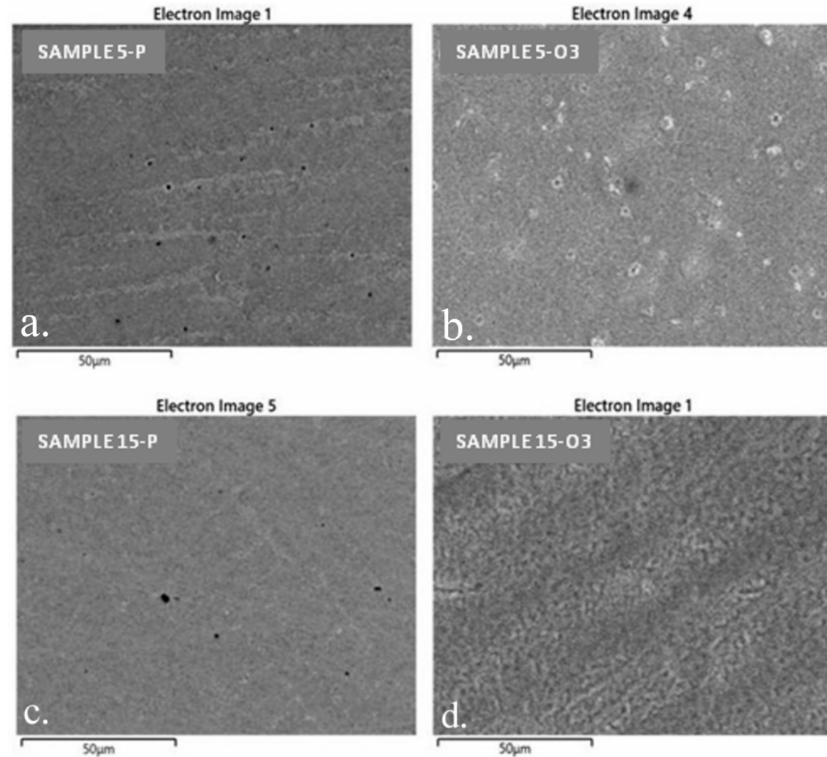
Figure 8. SEM images: ( a ) sample 5-P; ( b ) sample 5-O3; ( c ) sample 15-P; ( d ) sample